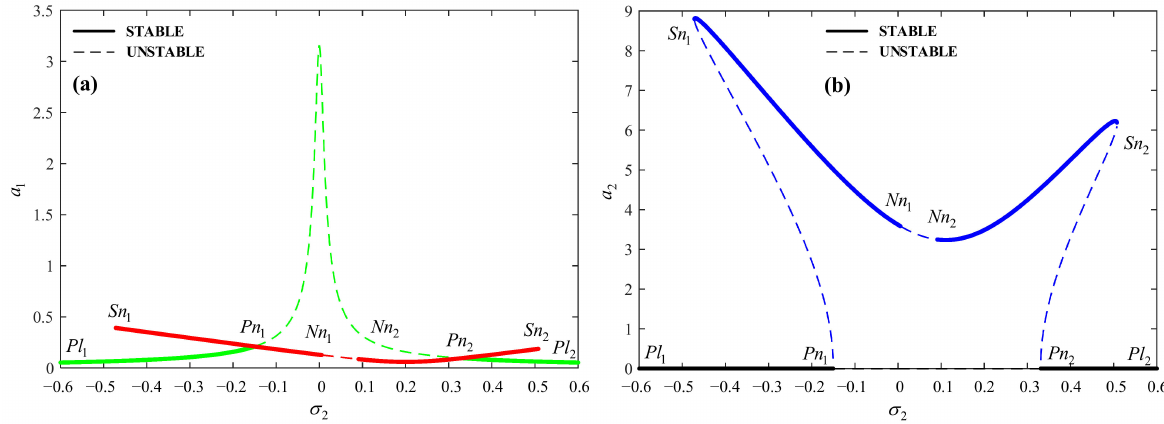
Figure 7. Effect of σ 2 on frequency-response curves of ( a ) flexible manipulator and ( b ) vibration absorber (when σ 1 =